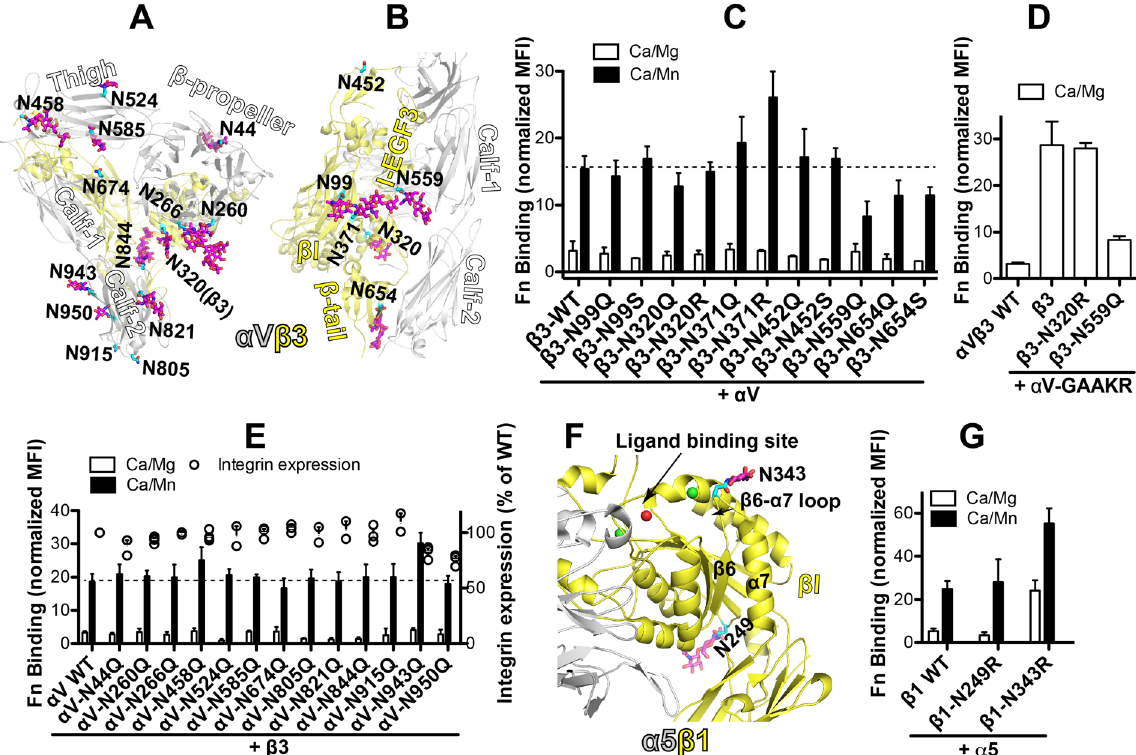
Figure 8. Effect of N-glycan deletions on α V β 3 and α 5 β 1 ligand binding. (A) Locations of α V N-glycan sites in the crystal structure of α V β 3 (PDB code 4G1E). (B) Locations of β 3 N-glycan sites in the crystal structure of α V β 3 (PDB code 4G1E). Asn residues are shown as sticks with carbons in cyan. N-glycan residues resolved in the crystal structure are shown as sticks with carbons in magenta. Oxygens and nitrogens are red and blue, respectively. (C) Fibronectin (Fn) binding of HEK293FT- α 5 β 1 -KO cells transfected with the β 3 WT or the glycan mutants and α V WT. (D) Fn binding of HEK293FT- α 5 β 1 -KO cells transfected with the indicated β 3 constructs and the α V -GAAKR mutant that mimics integrin inside-out activation. (E) Fn binding of HEK293FT- α 5 β 1 -KO cells transfected with the α V WT or the glycan mutants and β 3 WT. (F) Locations of selected N-glycans at the β I domain of β 1 integrin in the crystal structure of α 5 β 1 headpiece (PDB code 4WJK). Asn and glycans are shown as sticks. Color codes are the same as panels A and B. Metal ions at the ligand-binding site are shown as spheres. (G) Fn binding of HEK293FT- α 5 β 1 -KO cells transfected with the β 1 WT or the selected glycan mutants and α 5 WT. Fn binding was done in the presence of 1 mM Ca 2 + /Mg 2 + (Ca/Mg) or 0.2 mM Ca 2 + plus 2 mM Mn 2 + (Ca/ Mn). Data are means ± s.e.m. (n =